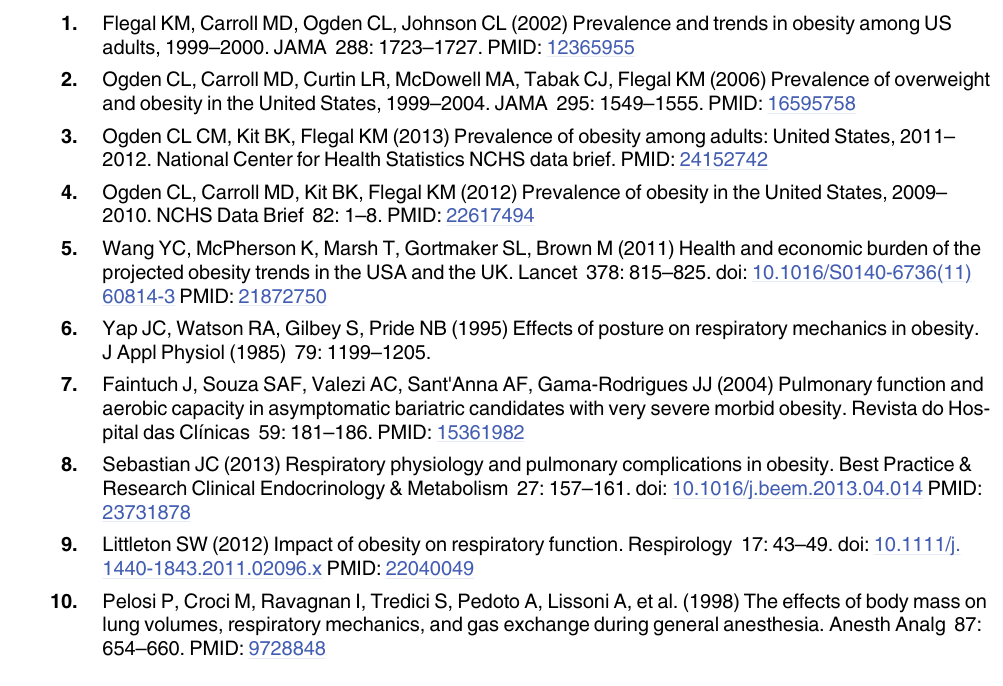
S1 Fig. Effects of BMI on FEV1/FVC (top left), DLCO (top right), ERV (bottom left) and FRC (bottom right). The horizontal solid lines are significant differences between-group com- parisons from ANOVA and post hoc